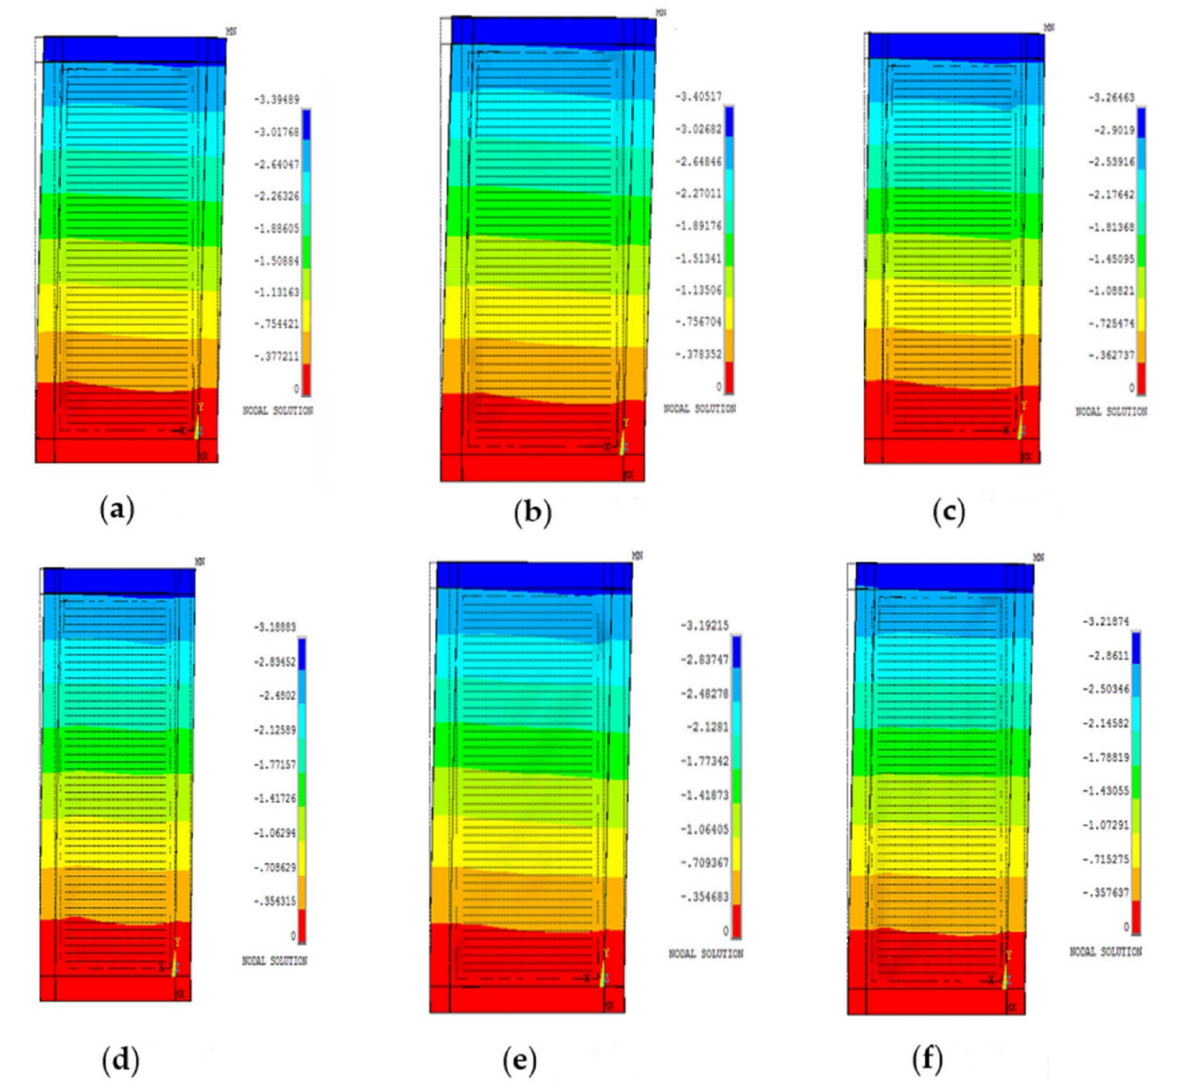
Figure 24. Effect of shear stud layout on the lateral displacement. ( a ) (3 × 8), ( b ) (8 × 3), ( c ) (4 × 6), ( d ) (6 × 4), ( e ) (2 × 12), ( f ) (12 × 2).